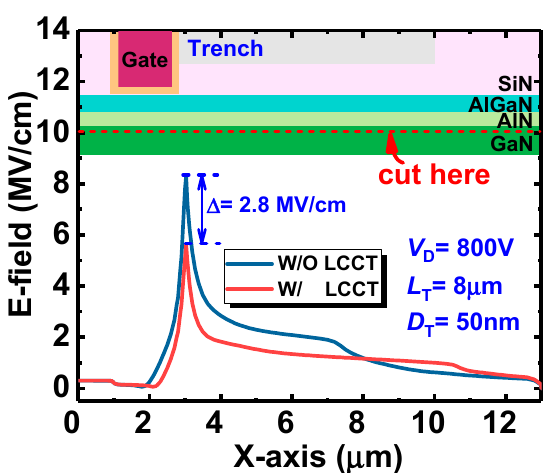
Figure 10. The E-field distribution along the channel in LCCT-HEMT when the drain voltage is 800 V.